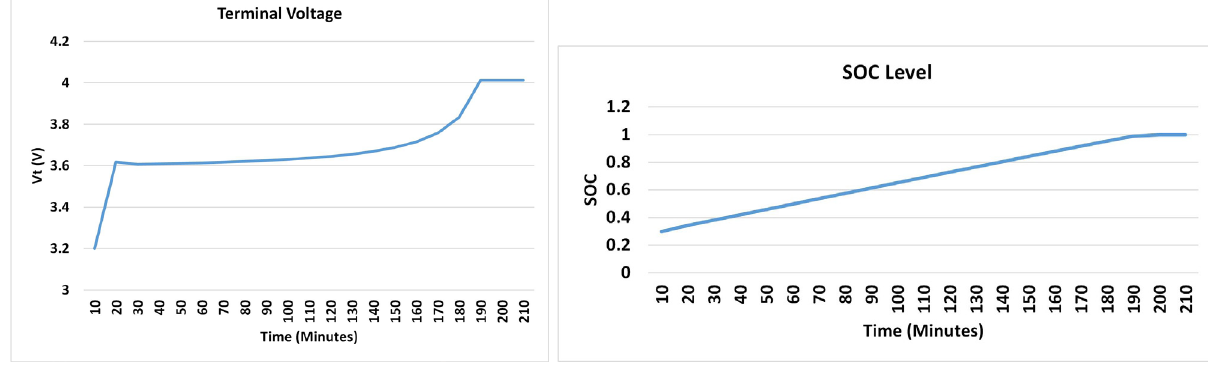
Figure 4: Terminal voltage and SOC values of one EV.